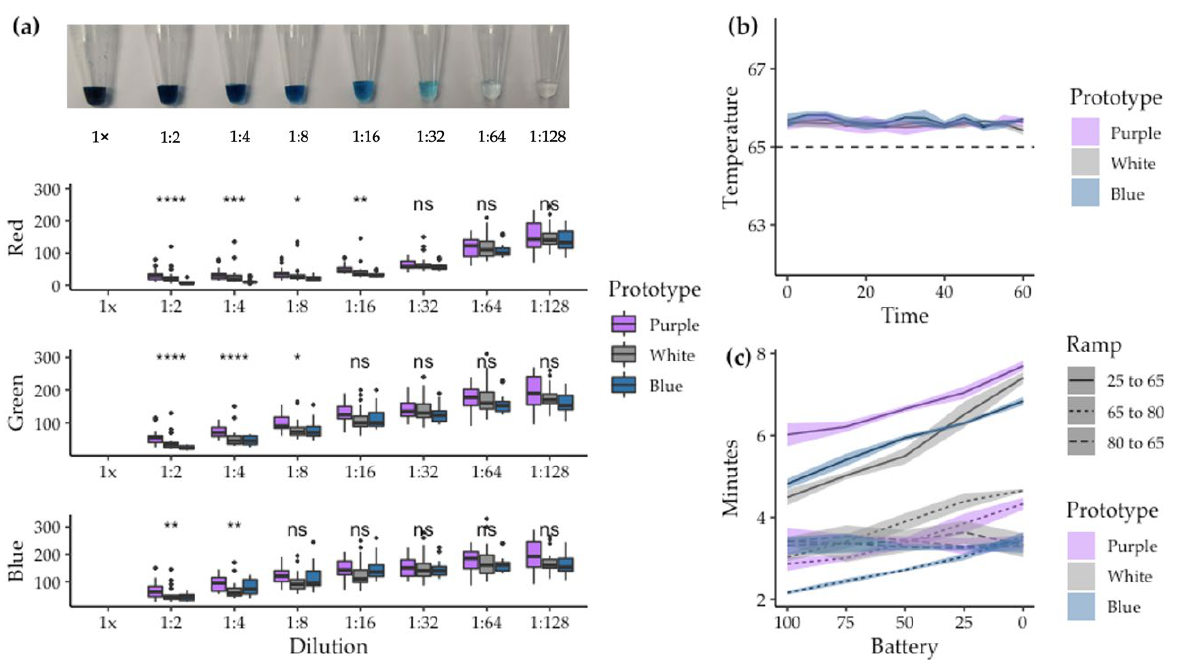
Figure 2. Basic measurements of color readout and temperature profile of the SMART-LAMP devices: ( a ) Color readout of the SMART-LAMP with MG dilutions in water. In the top picture, 15 μL of MG dilutions in water in 0.2 mL Eppendorf tubes are presented, ranging from a 0.1% w / v dilution (1×) down to 7.81 × 10 − 4 % w / v (1:128), in a 2-fold serial dilution fashion. Boxplots representing RGB values for all eight dilutions are presented (from top to bottom: Red component, Green component and Blue component), measured in triplets in each well of each prototype. ANOVA-test results comparing the three prototypes are presented. (n/s: non-significant, *: p -value ≤ 0.05, **: p -value ≤ 0.01, ***: p -value ≤ 0.001, ****: p -value ≤ 0.0001). ( b ) Temperature profile for one hour reaction at 65 ◦ C in each prototype. Measured in triplets. ( c ) Ramping times to achieve reaction temperature (65 ◦ C) from room temperature (25 ◦ C), from reaction temperature to inhibition temperature (80 ◦ C) and from inhibition temperature back to reaction temperature. Measured for different battery percentages. Each measurement was taken in